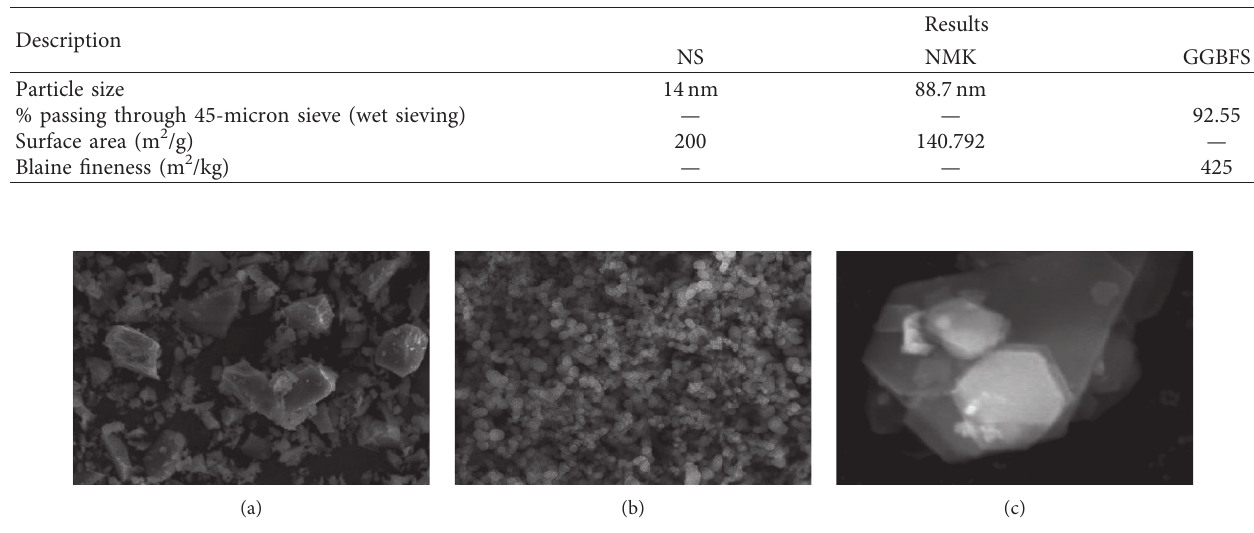
Table 2: Physical properties of NS and GGBFS.